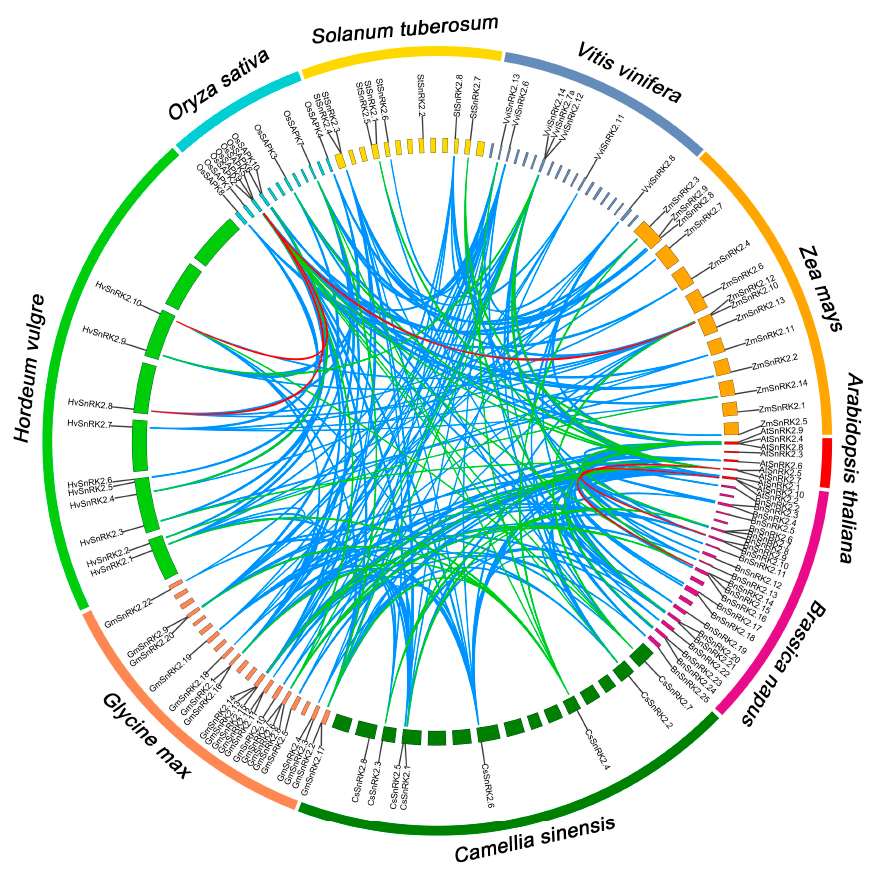
Figure 4. Synteny analysis among 122 SnRK2 genes. The synteny relationship between each pair of SnRK2 genes was detected using linear regression. Lines of different colors represent the similarity of sequences: red, > 95%; 75% = blue ≤ 95%; green, < 75%. To further explore the evolutionary relationships of StSnRK2 genes, intergenomic comparison relationships maps between potato and two representative species (a dicot (Arabidopsis) and a monocot (rice)) were constructed. The results show that 11,048 ho- mologous gene pairs were detected in potato and Arabidopsis, and the distribution shows